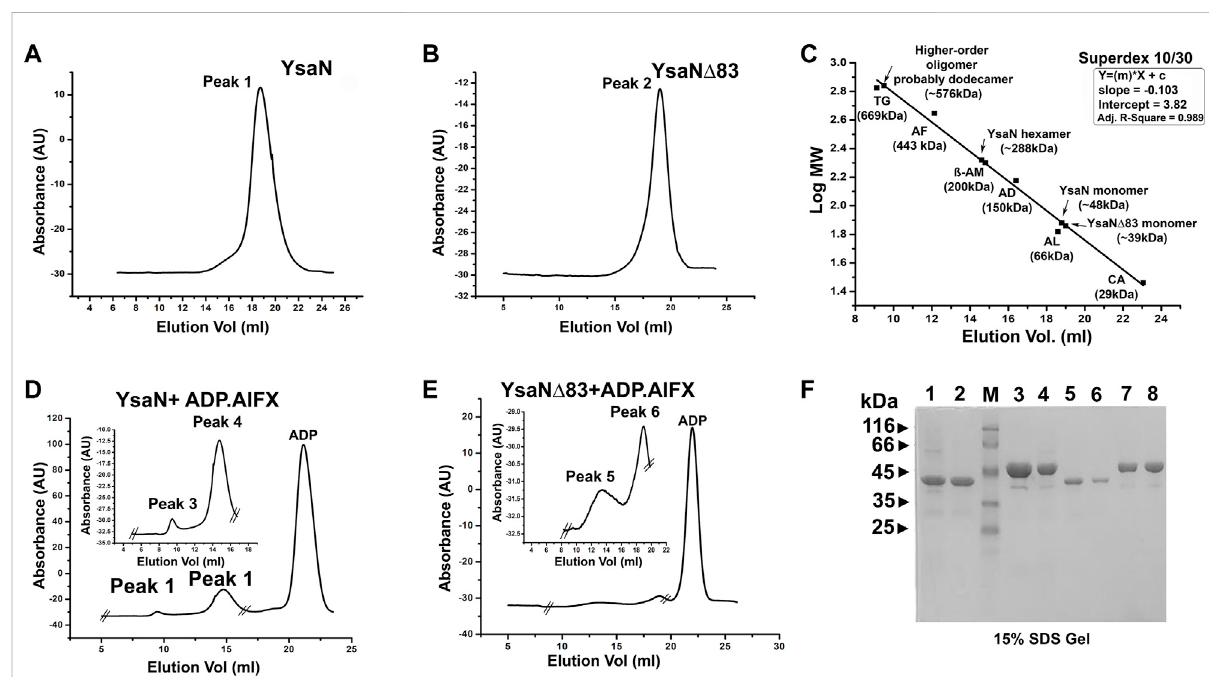
FIGURE 4 Analytical size exclusion chromatography pro fi le of YsaN and YsaN Δ 83 using Superdex 10/30 column - (A) and (B) - size-exclusion pro fi le of puri fi ed monomeric YsaN and YsaN Δ 83 respectively. (C) - molecular weight standard curve for Superdex 10/30 column representing elution pro fi les of possible oligomeric forms of YsaN and YsaN Δ 83. (TG = Thyroglobulin- 669 kDa, AF = Apoferritin 443 kDa, β -AM = β - Amylase- 200 kDa, AD = Alcohol dehydrogenase- 150 kDa, AL = Albumin- 66 kDa, CA = Carbonic anhydrase- 29 kDa). (D) and (E) - size-exclusion pro fi le of YsaN and YsaN Δ 83 in presence of 1.5 mM ADP.AlFX in the buffer containing 5 mM NaF, inset showing peaks corresponding to probable dodecamer and hexamer respectively in the zoomed image delimited by crossed section in the full chromatogram. (F) - SDS gel pro fi le of the puri fi ed sample and peaks collected during size exclusion chromatography steps. Lane 1 and Lane 3 represent puri fi ed YsaN Δ 83 and YsaN form Superdex 200 16/ 600 size exclusion chromatography column respectively. Lane 2 (YsaN Δ 83) and Lane 4 (YsaN) correspond to peak 2 of (B) and peak 1 of (A) respectively. Lane 3 represents the marker, and Lane 5 and 6 represent the peak 6 and peak 5 in (E) respectively. Lane 7 and 8 represent peak 3 and peak 4 in (D)